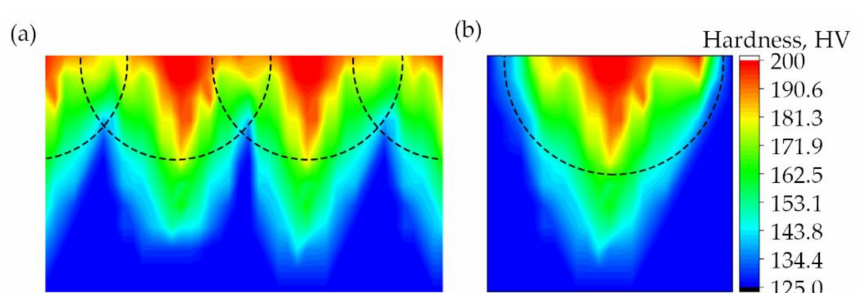
Figure 6. XRD pattern of the laser-processed layer.